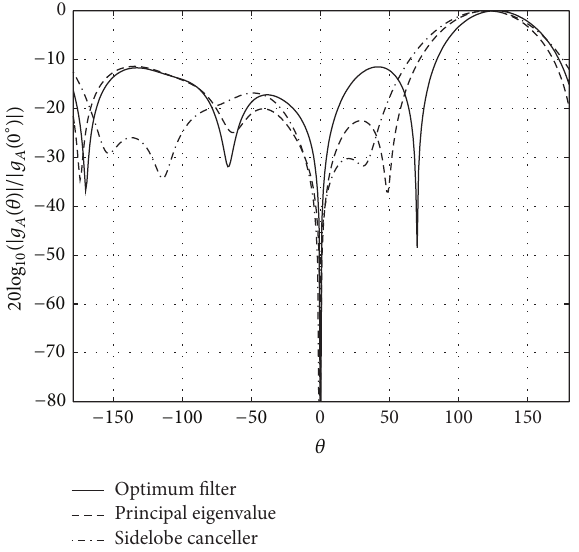
Figure 5: Examples of adaptive array patterns obtained by exploit- ing the optimum filter, the principal eigenvalue approach, and the Sidelobe Canceller for the case of two independent narrow-band interfering